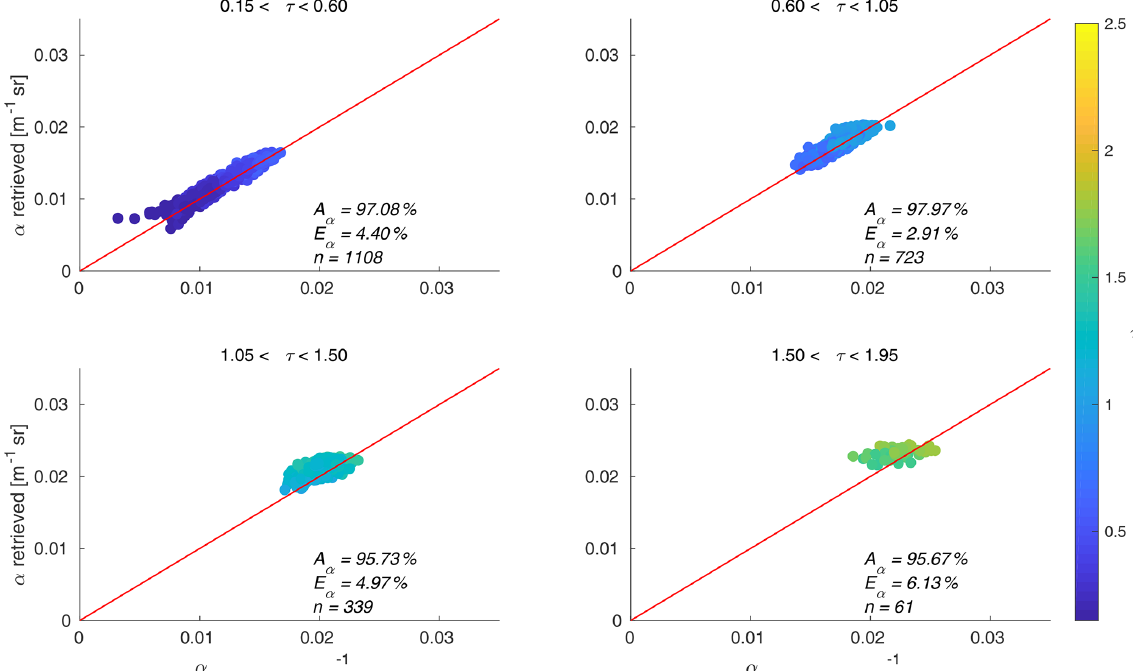
Figure 6. Scatterplots of the retrieved cloud optical extinction (with the multiple scattering and range resolution correction) versus the modelled cloud optical extinction from the ECSIM divided into panels depending on the value of the optical thickness. The red line is imposed and represents the equality between the modelled and retrieved values. The colour bar represents the value of the cloud optical thickness at each point. The error E α (Eq. 15) and accuracy A α (Eq. 16) for each bin of the optical thickness are also presented.